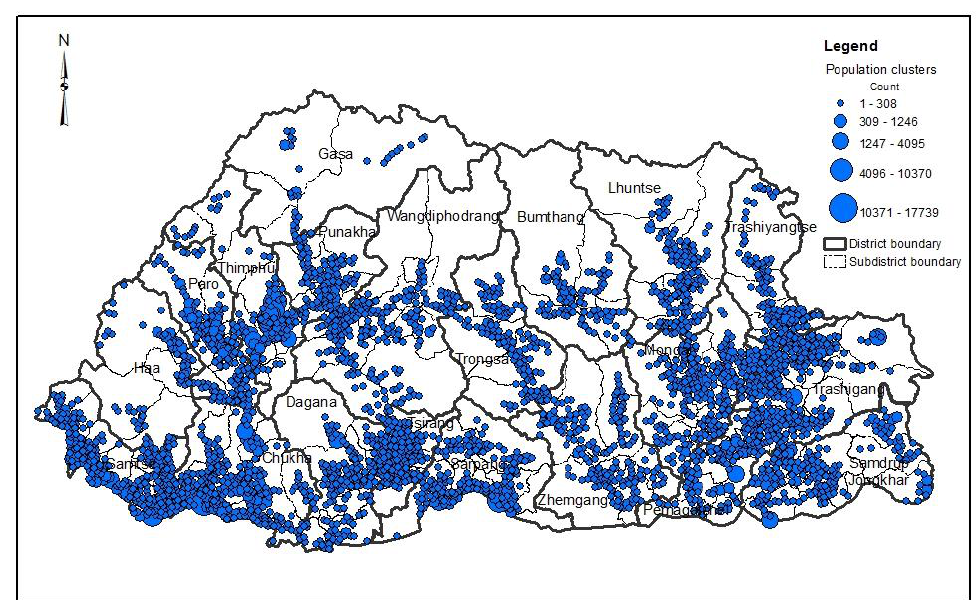
Figure 2: Distribution of population